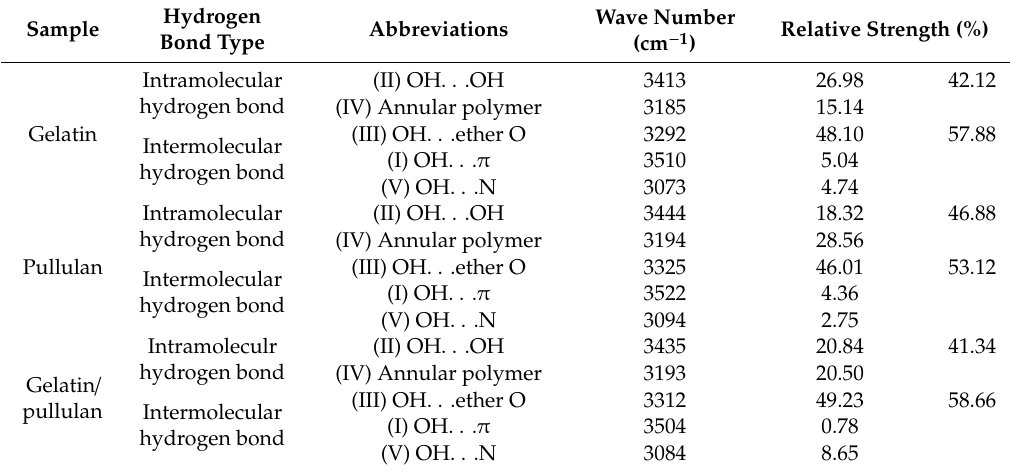
Table 1. The fitting results of various kinds of hydrogen bonds.